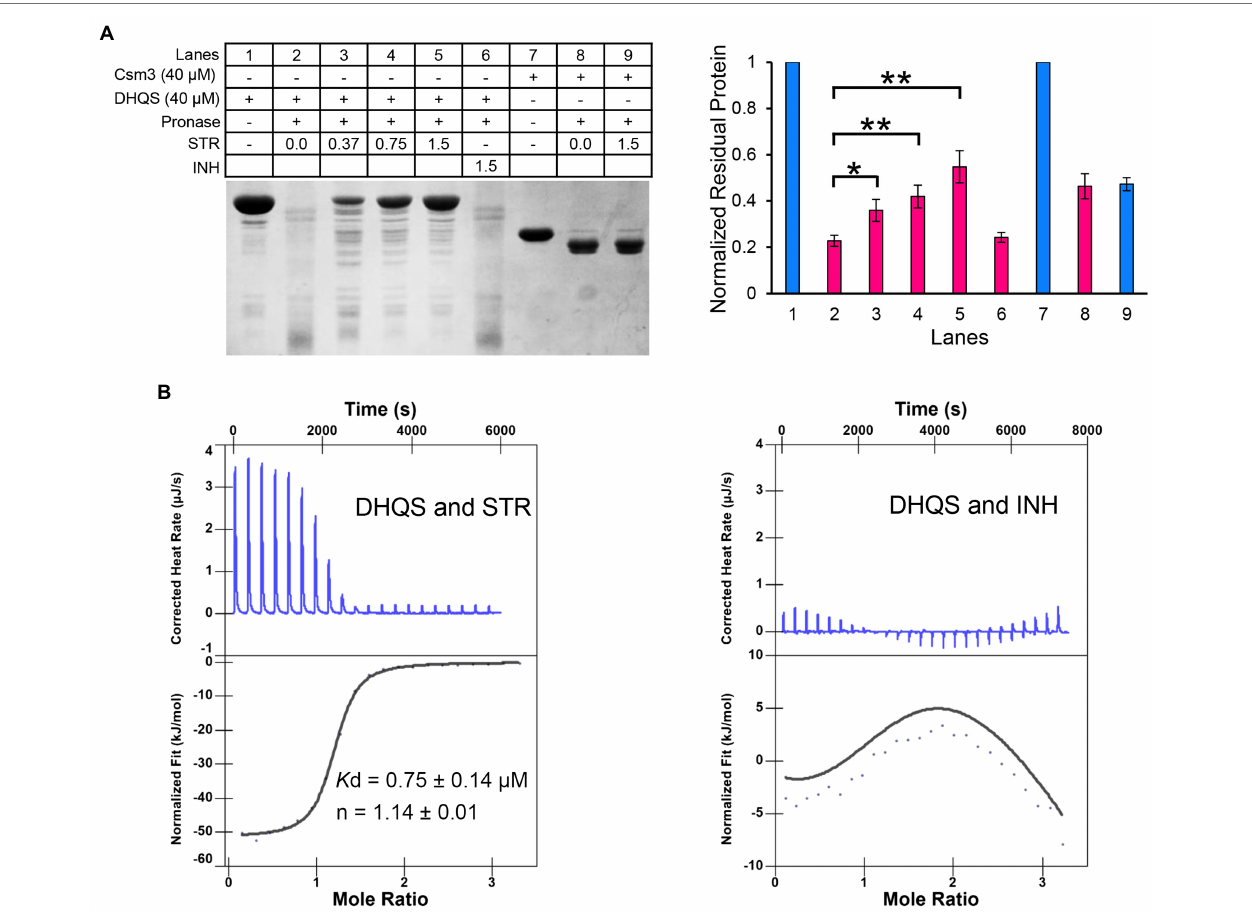
FIGURE 3 | Dehydroquinate synthase directly binds to streptomycin. (A) Binding analysis of streptomycin and DHQS by drug affinity response target stability (DARTS). About 40 μ M DHQS was incubated with increasing concentrations of streptomycin (0.37, 0.75, and 1.5 mM) or 1.5 mM INH (negative control) for 30 min at 37 ° C, followed by digestion with 180 ng of pronase E for 30 min at 37 ° C. All the samples were subjected to a 12% w/v SDS-PAGE. The amount of protein degradation at each concentration was quantified with the non-digested lane as internal reference. Barplot shows the mean and SD of three biological replicates. p -values were calculated by GraphPad Prism 8 with an unpaired two-tailed Student’s t -test. Asterisk represents the significant difference between the two groups of data (* p < 0.05, ** p < 0.01). (B) Isothermal titration calorimetry (ITC) analysis of 50 μ M DHQS binding with 1 mM streptomycin (left) or 1 mM isoniazid (right). Original titration data and integrated heat measurements are shown in the upper and lower panel, respectively. The solid line in the left lower panel represents the best fitting of a single-site binding model of DHQS and streptomycin, while right lower panel shows no interaction between DHQS and